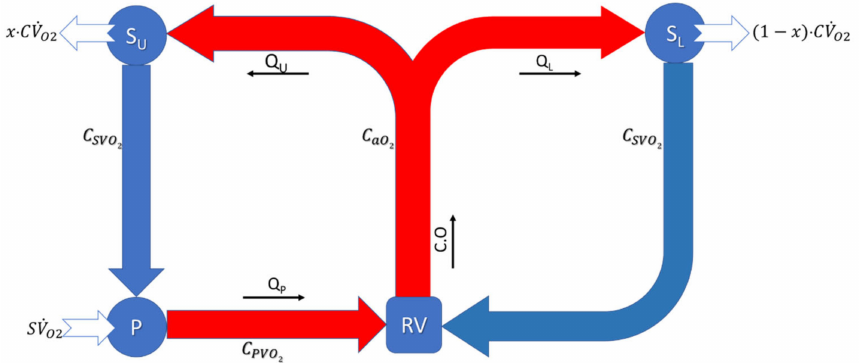
Figure 12. Generic oxygen transport model schematic of HCSII circulation (RV = Right Ventri- cle, S U = Upper Systemic circulation, S L = Lower systemic circulation, P = Pulmonary circulation, CO = cardiac output [L/min], Q U = Upper body flow [L/min], Q L = Lower body flow [L/min], C xxO2 = Oxygen concentration (mL O 2 / mL of blood) for a = arterial; sv = systemic venous; pv = pul- . V O 2 = 9. m [mL/min], systemic oxygen consumption with m = patient weight [Kg] monary venous, C . x = oxygen consumption split ratio, S V O 2 = Oxygen uptake in the